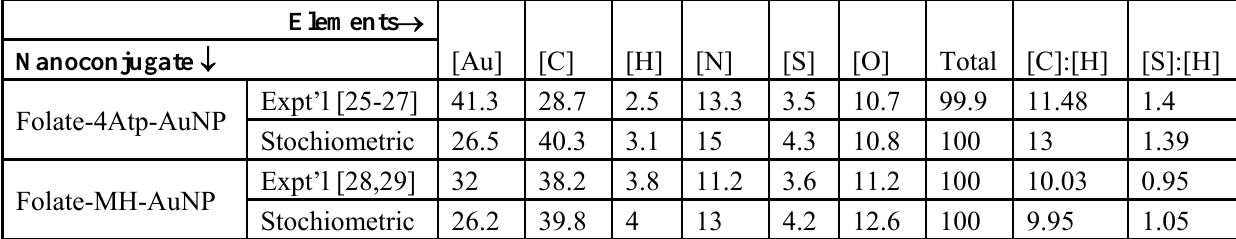
Table 1 . Elemental analysis data of the